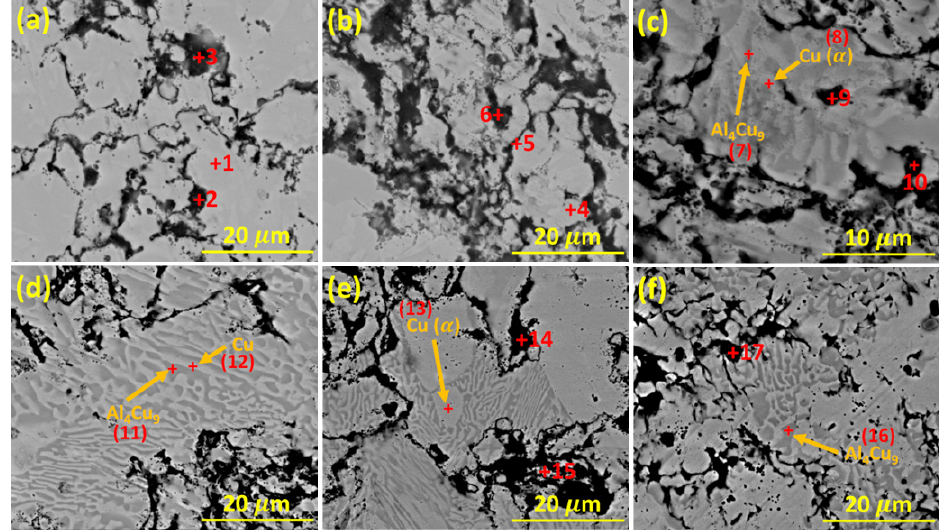
Figure 7. Backscattered SEM micrograph of compacted samples after sintering, ( a ) unmilled power at 750 °C, ( b ) C1T2, ( c ) C2T1, ( d ) C2T2, ( e ) C2T3, and ( f ) C3T2.